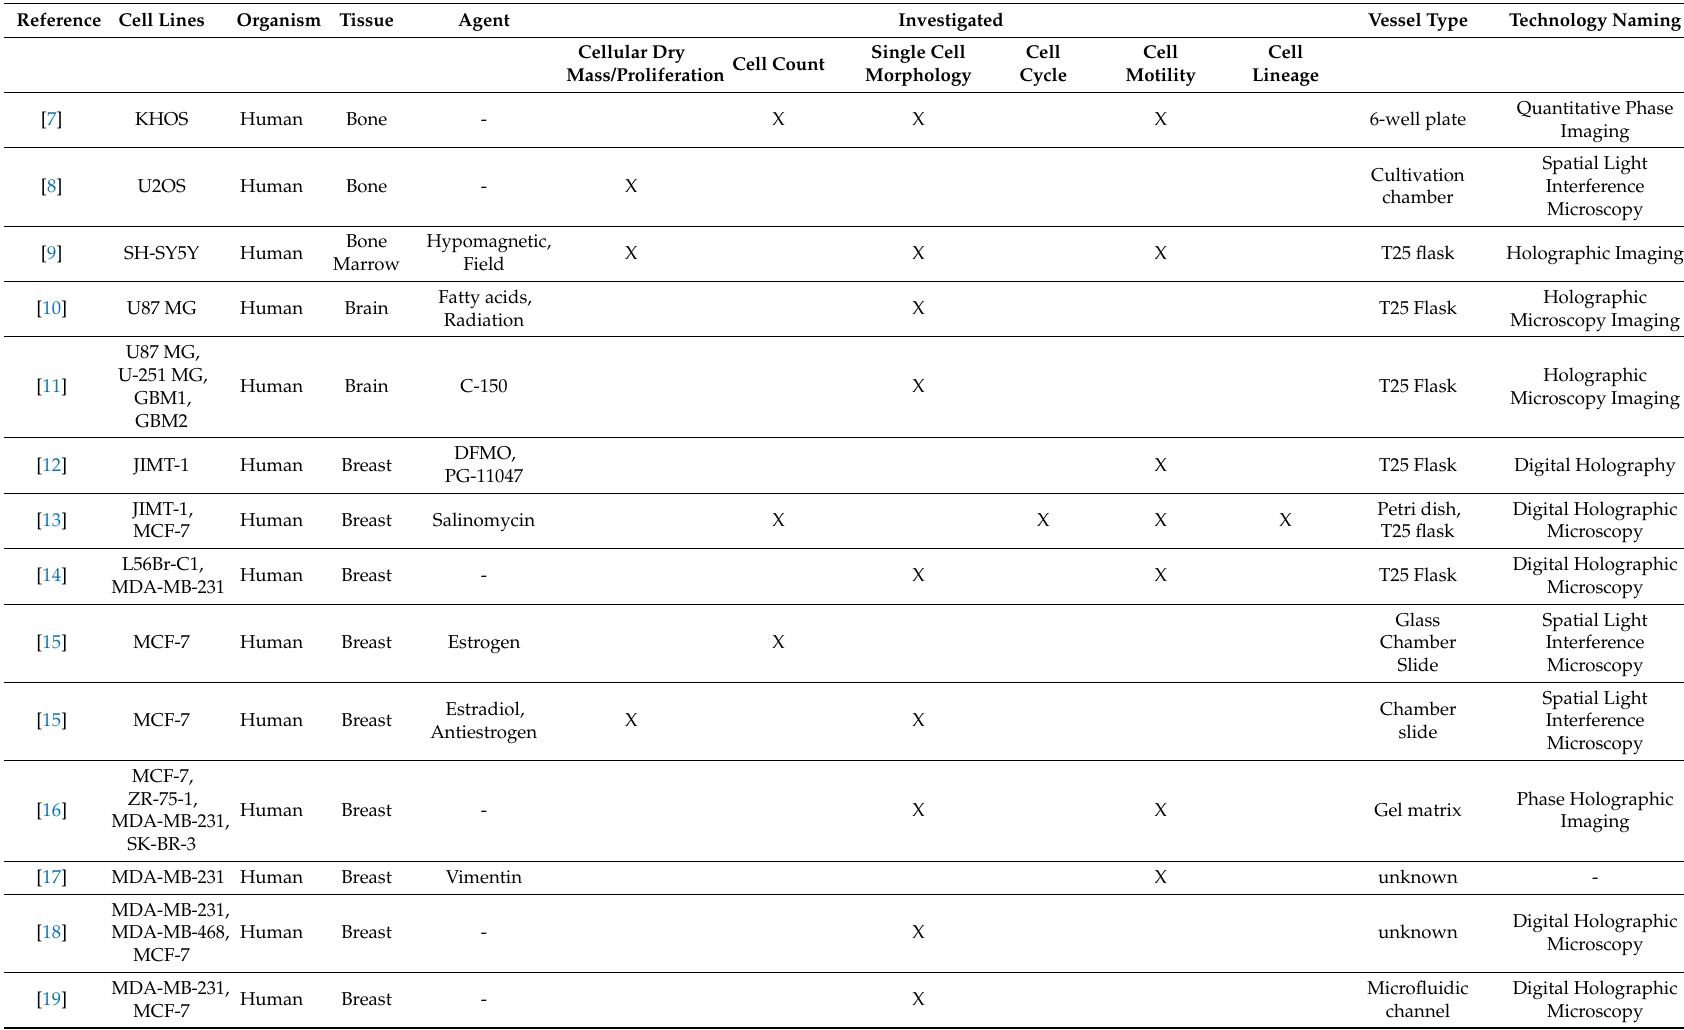
Table 1. Summary of type of material and treatment used to analyze cancer specimens with quantitative phase imaging (QPI). Reference Cell